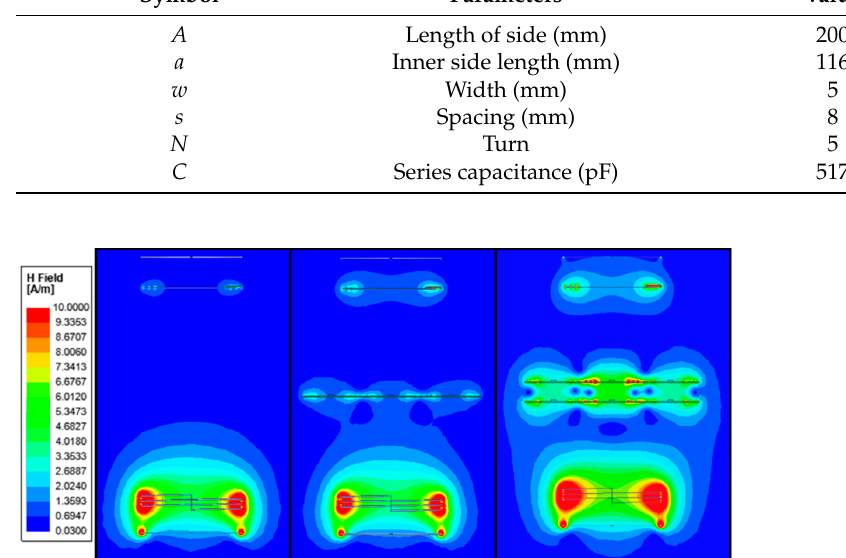
Figure 8. Relationship between PTE and d tm with one MM slab. Based on the previous simulation results, in order to obtain a larger magnetic field for the Rx coil, we used a combination of two MNM-MM slabs. The spacing g m between two slabs is an important parameter. Figure 9a shows the change curve of PTE as g m in- creased when d tr = 100 cm and MM slabs were placed at d tm = 60 cm. The highest PTE was 64.33% at g m = 8 cm. Compared with the PTE of a system without MMs, it was improved by 33.83%. The experimental measurements showed that the maximum PTE was obtained at an optimal spacing. After determining the optimal g m , the influence of distance d tm be- tween two MM slabs and Tx coil on PTE was explored, and the result is shown in Figure 9b. As was the case when using one MM slab, the PTE increased the most when the MM